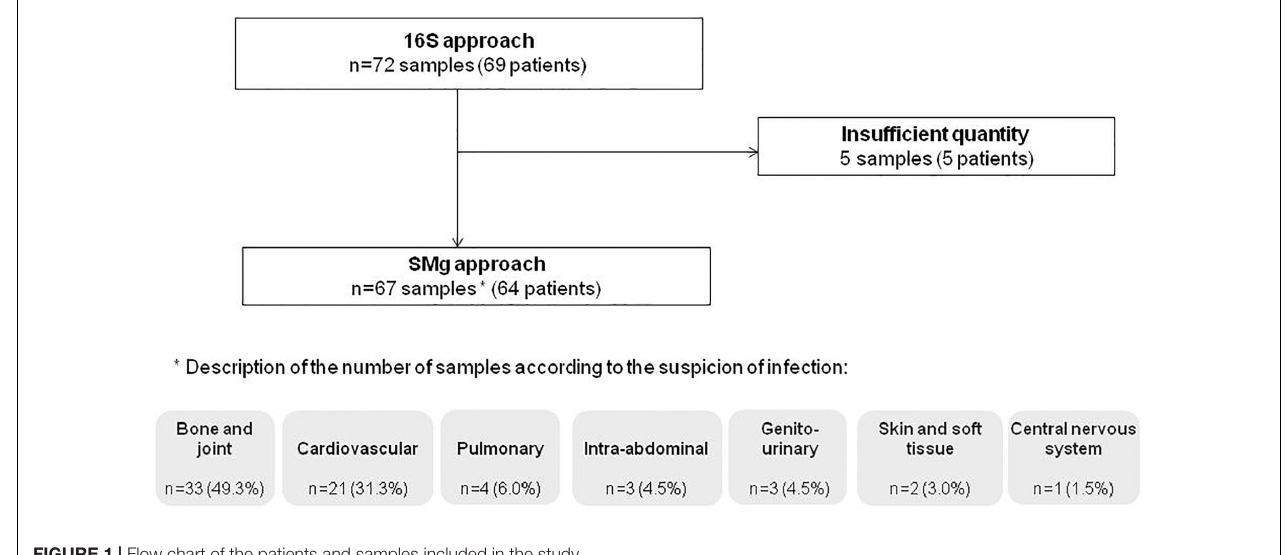
FIGURE 1 | Flow chart of the patients and samples included in the